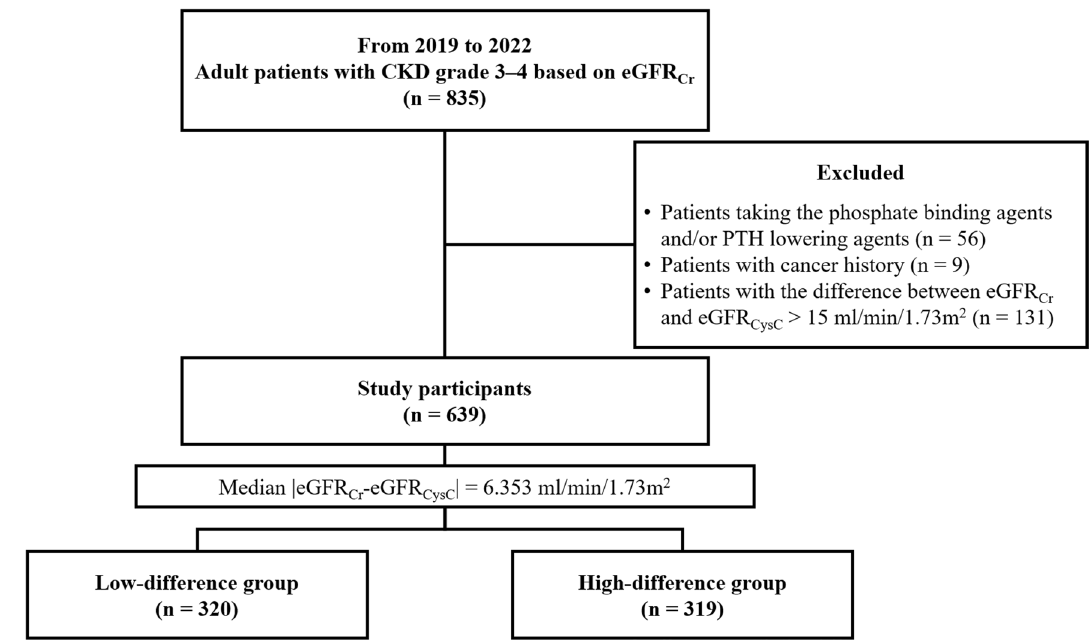
Figure 5. Study design. Of the 835 patients with CKD grades 3 and 4 based on the eGFR Cr , 196 were excluded according to the exclusion criteria, and 639 were finally included. Patients were divided into two groups based on a median |eGFR Cr -eGFR CysC | of 6.353 ml/min/1.73 m 2 . CKD, chronic kidney disease; eGFR, estimated glomerular filtration rate; eGFR Cr , eGFR based on creatinine; eGFR CysC , eGFR based on cystatin C; PTH, parathyroid